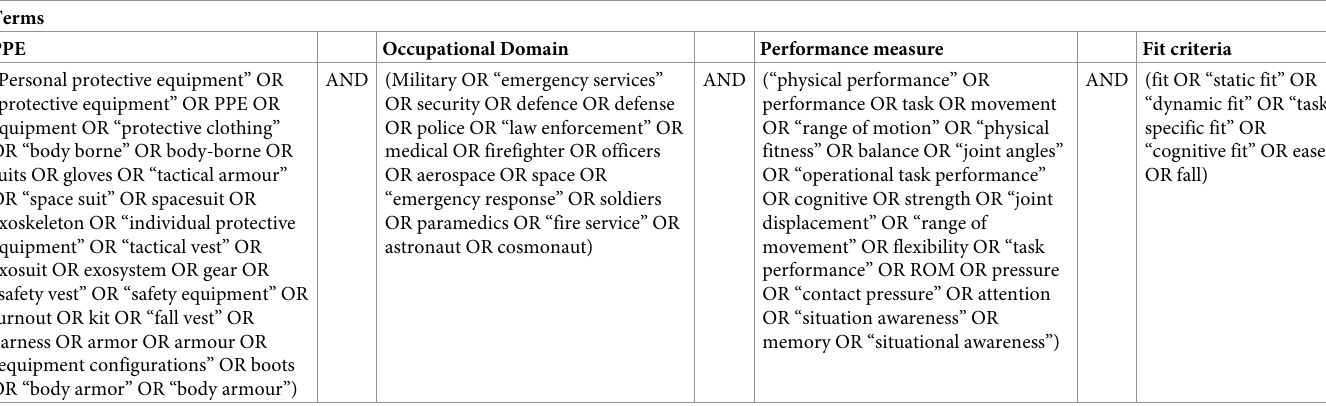
Table 1. The search strategy terms to identify studies relevant to the present